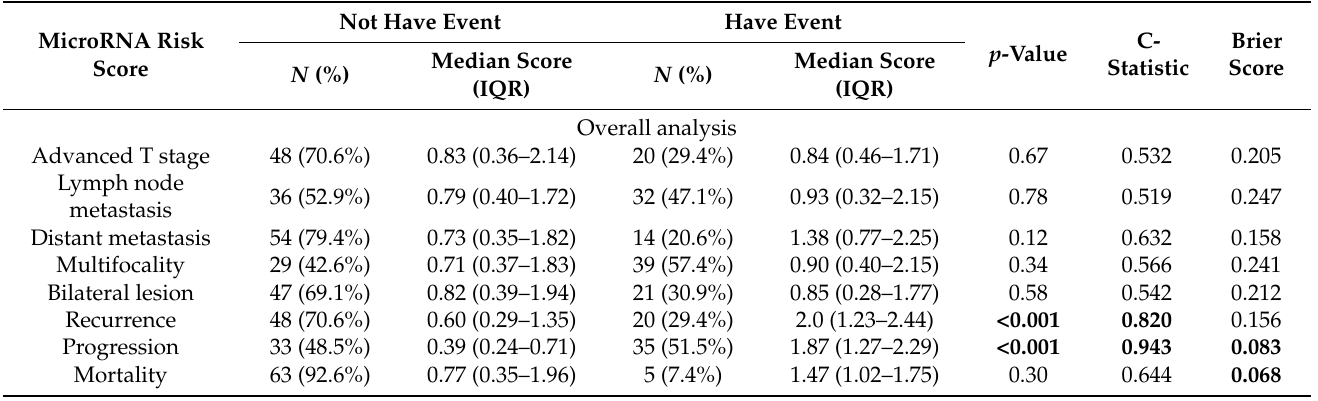
Table 6. Prognostic value of microRNA risk score in thyroid cancer